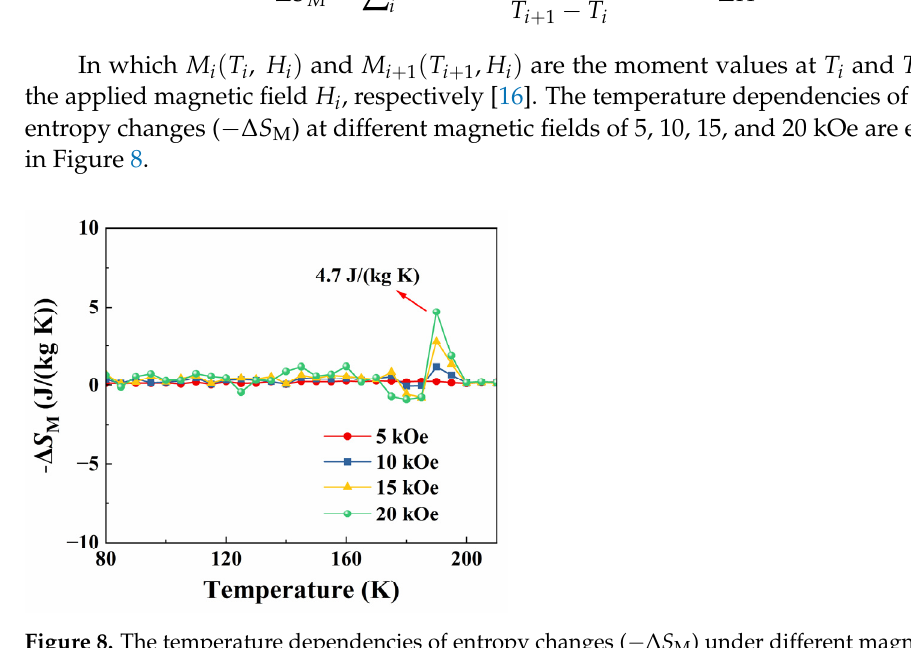
Figure 8. The temperature dependencies of entropy changes ( − ∆ S M ) under different magnetic fields of 5, 10, 15, and 20 kOe for PSMO film on SrTiO 3 .